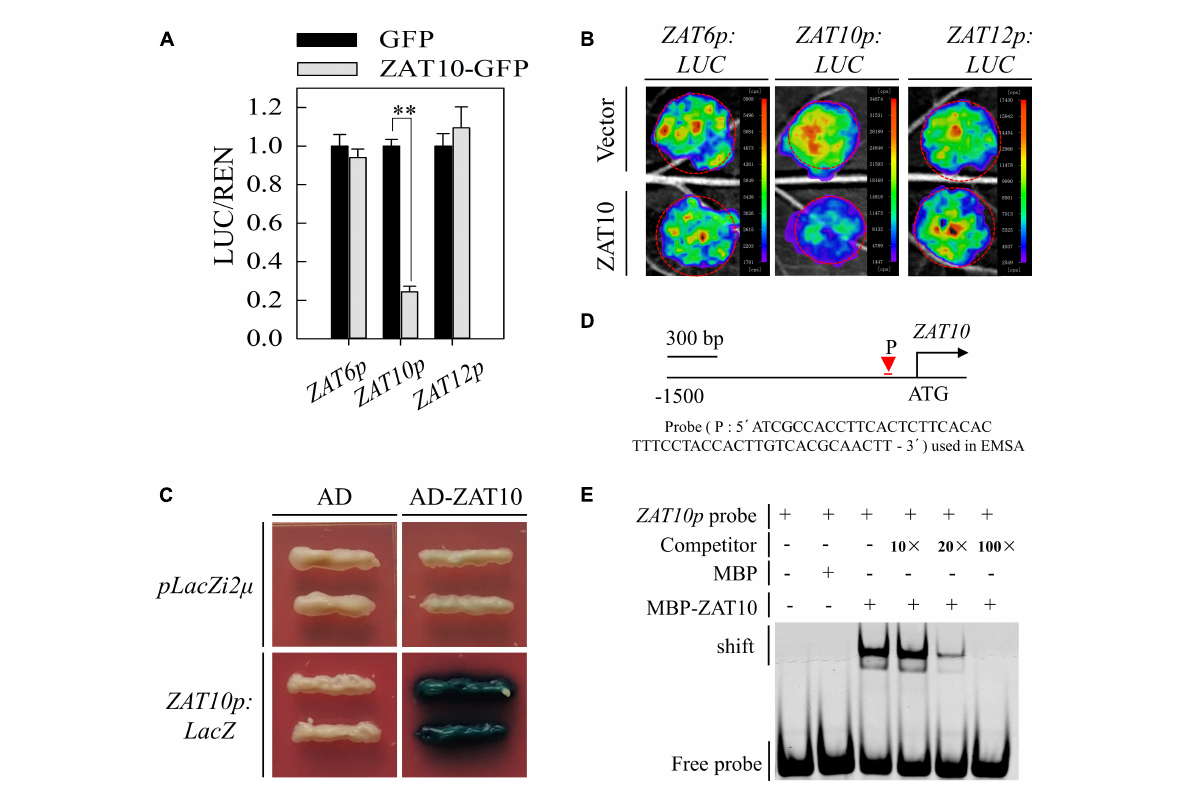
FIGURE7 ZAT10 directly binds to its own promoter and represses its expression. (A) ZAT10 represses ZAT10p:LUC in protoplast transient expression assays. The renilla was used as an internal control. LUC/REN ratio represents the relative activity of the ZAT6, ZAT10, and ZAT12 promoters. Means ± SD, n = 3; ** P < 0.01, Student’s t -test. (B) Transient expression assays of luminescence intensity show that ZAT10 represses the transcriptional activity of ZAT10 promoter in N. benthamiana leaves. The ZAT6p:LUC , ZAT10p:LUC , and ZAT12p:LUC were co-infiltrated with empty vector or ZAT10 overexpression vector in N. benthamiana leaves as indicated. Images were taken at 48 h after infiltration. At least three replicates were measured with similar results. (C) Yeast one-hybrid assay shows that ZAT10 directly bind to the ZAT10 promoter. (D) Illustration of the probe (P) used in electrophoretic mobility shift assay. (E) EMSA analysis shows the direct binding of ZAT10 to the ZAT10